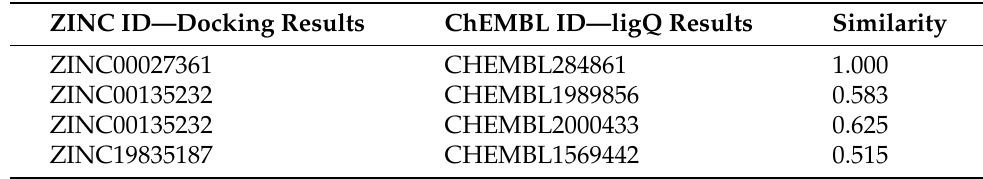
Table 3. Compounds detected by molecular docking in all the kinase models. The compounds share substructures with ligands found in the list of molecules similar to known kinase inhibitors. ZINC ID—Docking